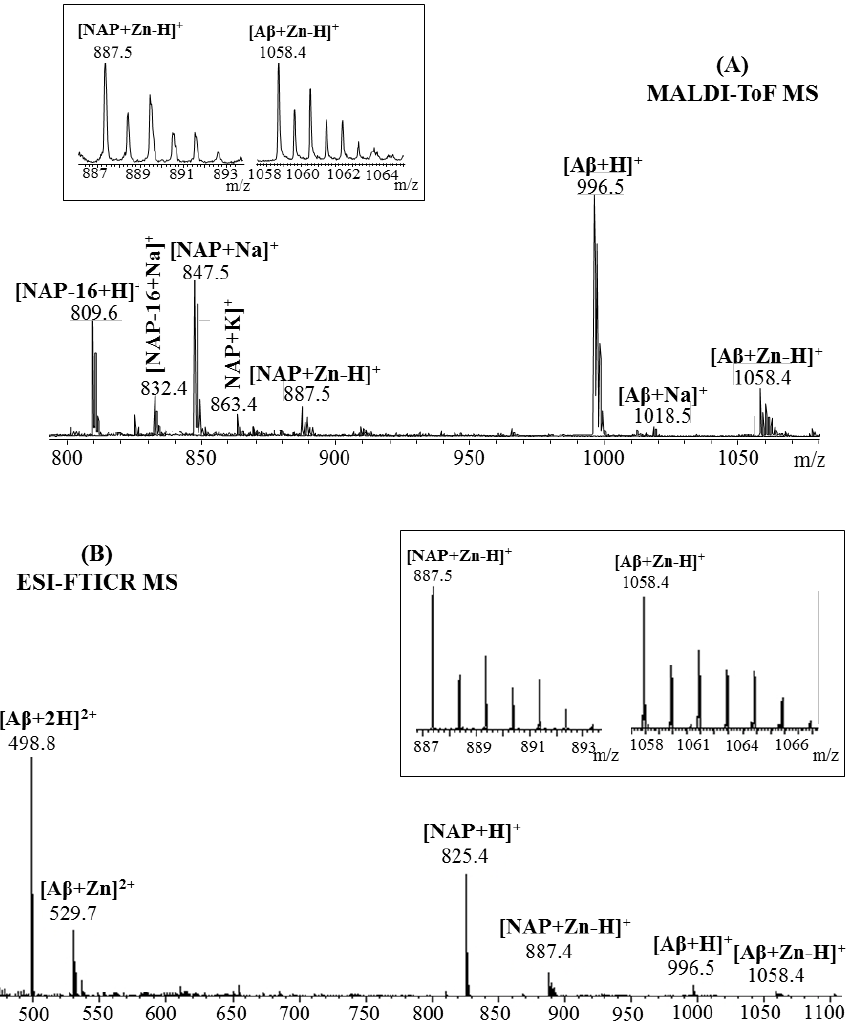
Figure 5. Enlarged region of mass spectra of both NAP and A β (9–16) peptide incubated with Zn 2+ ions acquired by ( A ) MALDI ToF (reflectron mode) with CHCA matrix and ( B ) ESI-FTICR, both in positive mode. Inserts: ( A ) details of theoretical and experimental isotopic patterns of [M + Zn-H] + ion; ( B ) details of the double-positive-charged peptide